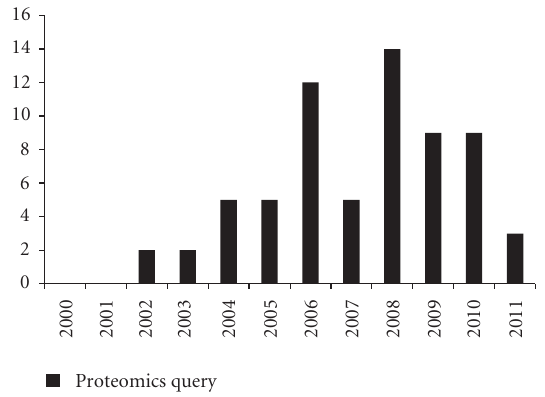
Figure 3: Pubmed Search. The number of research articles identified by Pubmed with the search terms “osteosarcoma” and “proteomics” since 2000. There have been fewer than 70 publica- tions thus